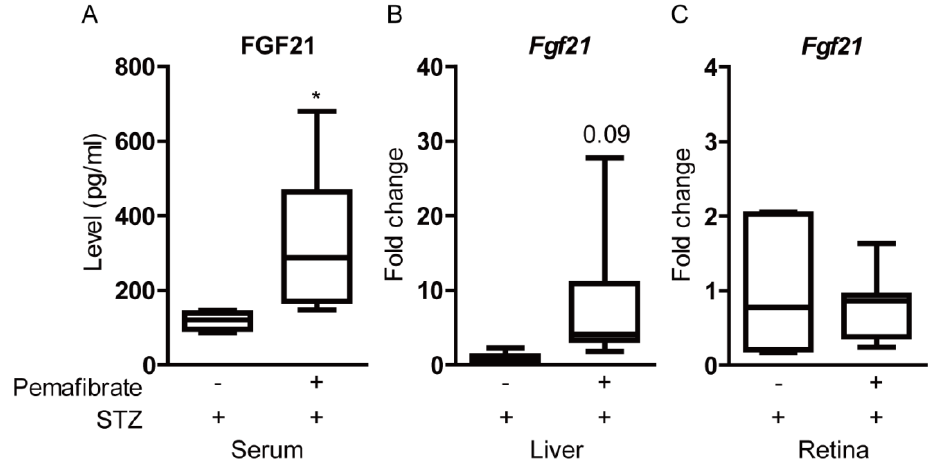
Figure 5. Increase of fibroblast growth factor21 (FGF21) level by the administration of pemafibrate in the STZ-induced diabetic mouse model. ( A ) Quantitative analysis showed that pemafibrate increased serum FGF21 level in STZ-induced diabetic mice ( n = 5–6 per group). ( B ) Quantitative analysis showed that pemafibrate slightly increased Fgf21 mRNA level in STZ-induced diabetic livers ( n = 6–7 per group). ( C ) Quantitative analysis showed that pemafibrate did not increase Fgf21 mRNA level in STZ-induced diabetic retinas ( n = 9–12 per group). * p < 0.05. Graphs are presented as median with interquartile range, the 25th and 75th percentile. The data were analyzed using Student’s t -test.